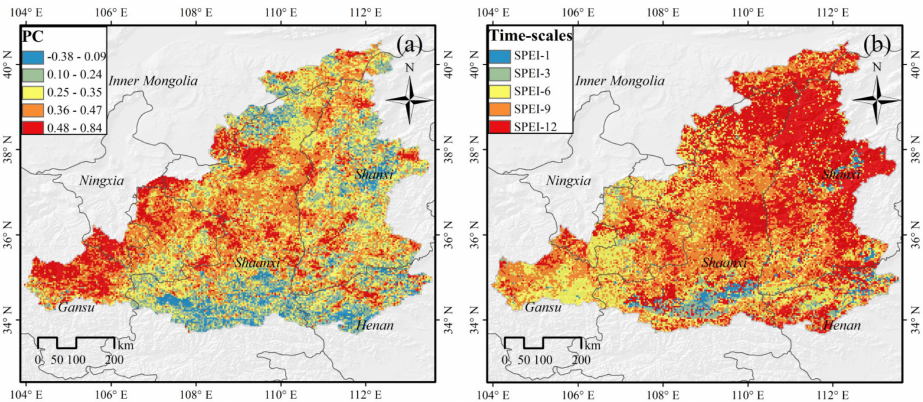
Figure 3. ( a ) The spatial pattern of the maximum correlation coefficient between NDVI and SPEI for the period of 2000–2018. ( b ) The time-scales at which the maximum correlation coefficient between NDVI and SPEI were